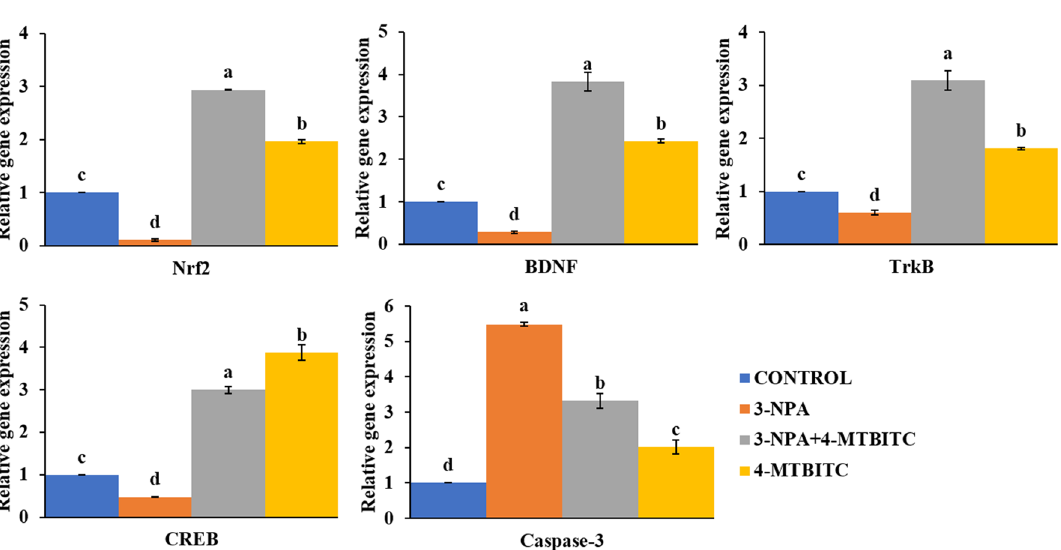
Figure 9. Relative gene expression of different genes Nrf2, BDNF, TrkB, CREB and Caspase-3 in SH-SY5Y cells by RT-qPCR. The values are represented as mean ± SE of three replicates and small letters as data labels indicate significant difference ( p < 0.05) between different treatment